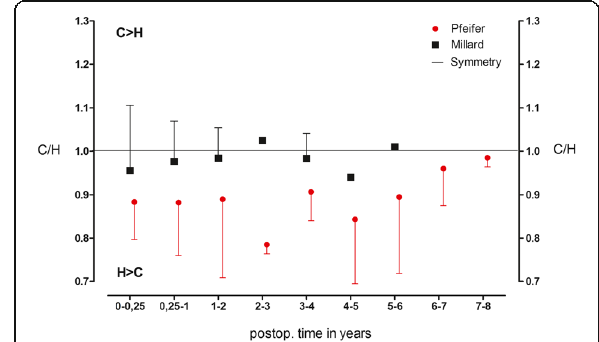
Fig. 5 Relation of total upper lip height. Symmetry quotient of the total lip height in the Millard group ( n = 36) compared to the Pfeifer group ( n = 44) ( p = 0.208). Presented as the means± standard